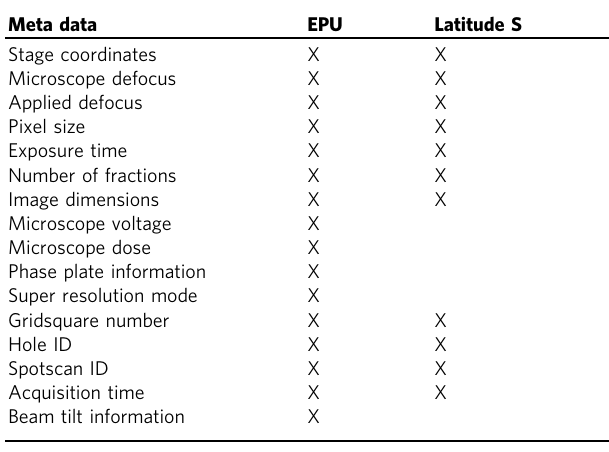
Table 2 Overview of all meta information extracted by TranSPHIRE. Meta